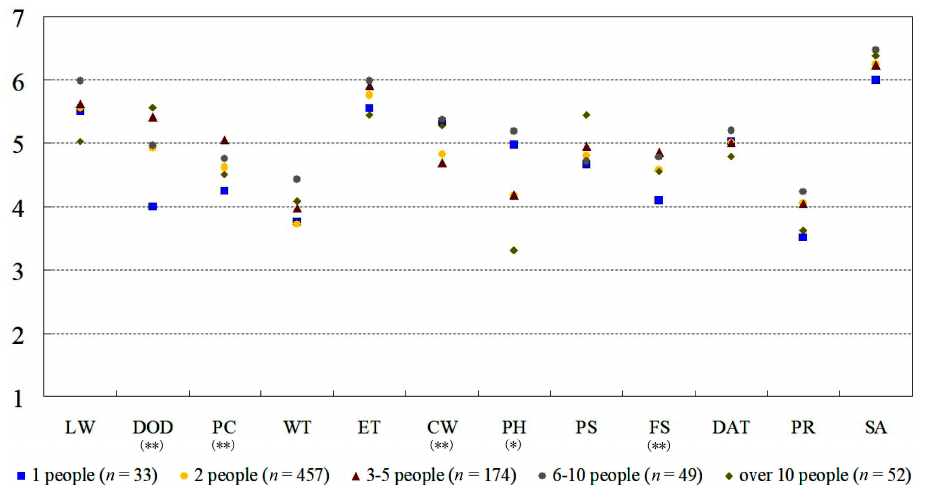
Figure 5. Choice preferences based on number of visitors. LW: Landscape the visitor wants to see; DOD: Degree of difficulty; PC: Pavement condition; WT: Watch the forest train; ET: Experience the forest bath; CW: Contact with landscape elements; PH: Photography; PS: Physical strength; FS: Facility status; DAT: Distance and time; PR: Privacy; SA: Satisfaction. ** Significant at the 0.01 level. * Significant at the 0.05 level.